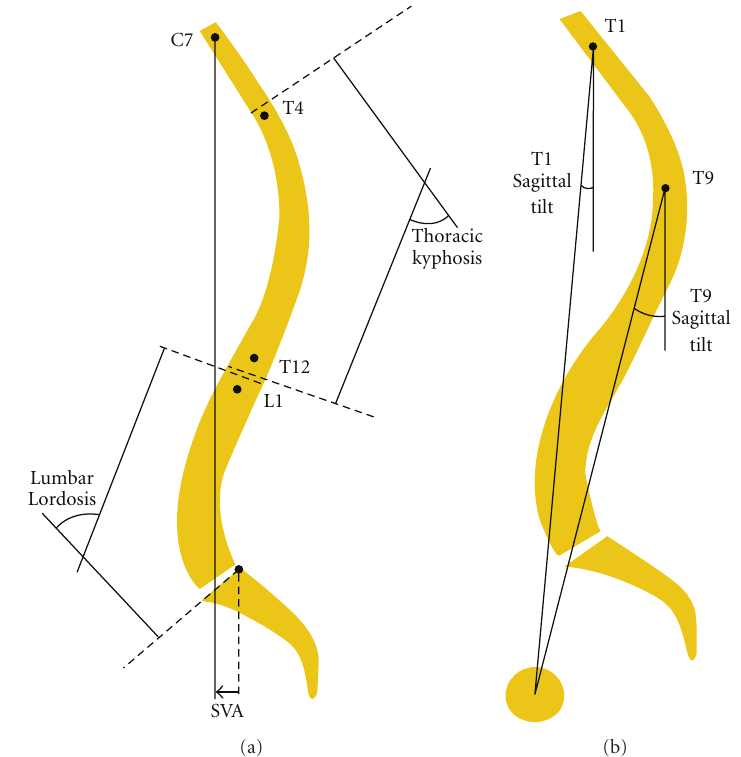
Figure 1: Sagittal spinal radiological parameters.